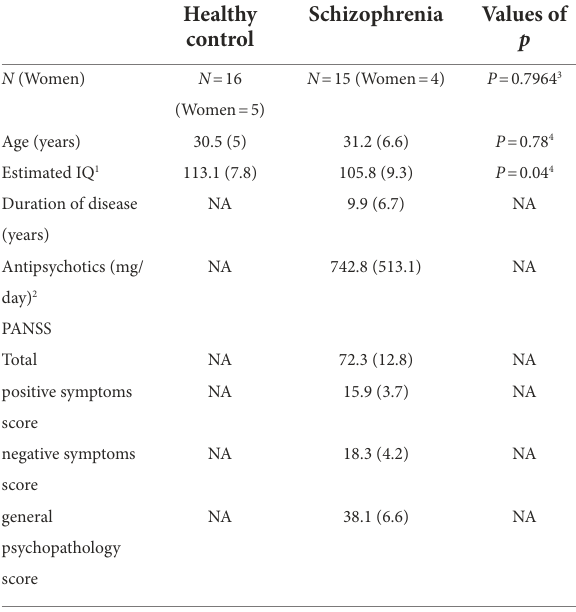
TABLE 1 Demographic background of healthy controls and patients with schizophrenia. Healthy Schizophrenia Values of control